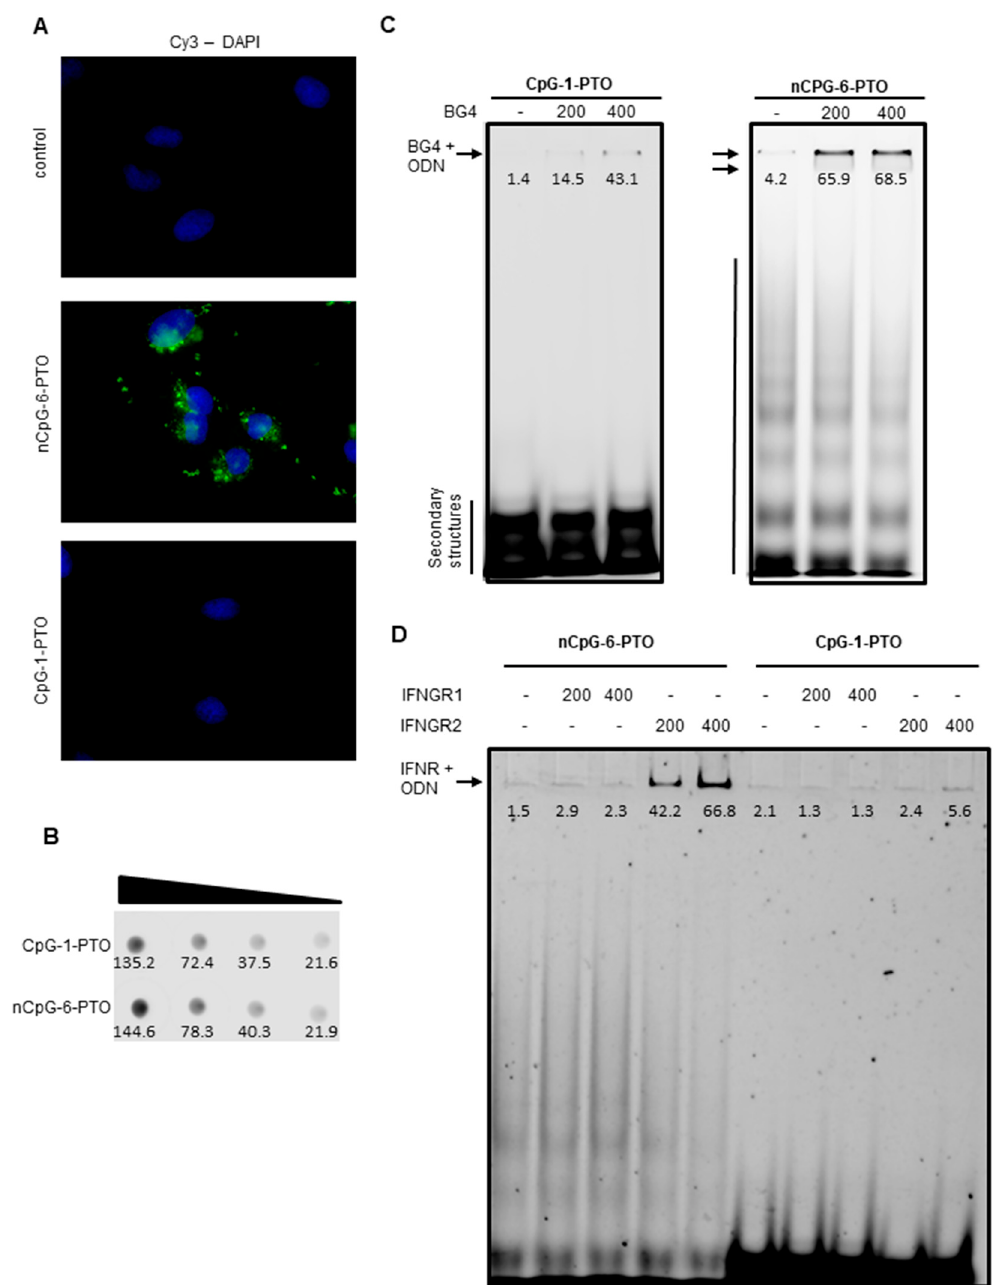
Figure 6. Cellular uptake of ODNs, G4 formation and binding to IFNGR. ( A ) A375 cells were treated with 4 μ M 5 ′ -Cy3-labelled CpG-1-PTO and nCpG-6-PTO for 24 h. The images show the presence of ODNs (green) in relation to the nuclei (DAPI, blue). ( B ) Dot blot analysis compared fluorescence intensities of a serial dilution (1:10) of 5‘-Cy3-labelled CpG-1-PTO and nCpG-6-PTO. ( C ) 0.2 μ g Cy3-labelled CpG-1-PTO and nCpG-6-PTO were either mixed with 200 ng or 400 ng G4-binding antibody BG4 and then separated by PAGE. ( D ) 0.2 μ g Cy3-labelled CpG-1-PTO and nCpG-6-PTO were either mixed with 200 ng or 400 ng IFNGR1 or IFNGR2 before separation by PAGE. The images show representative results.